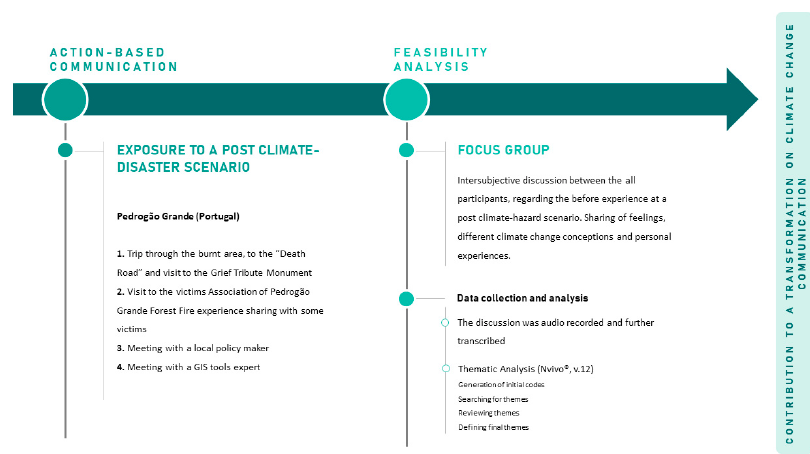
Figure 1. Study design.